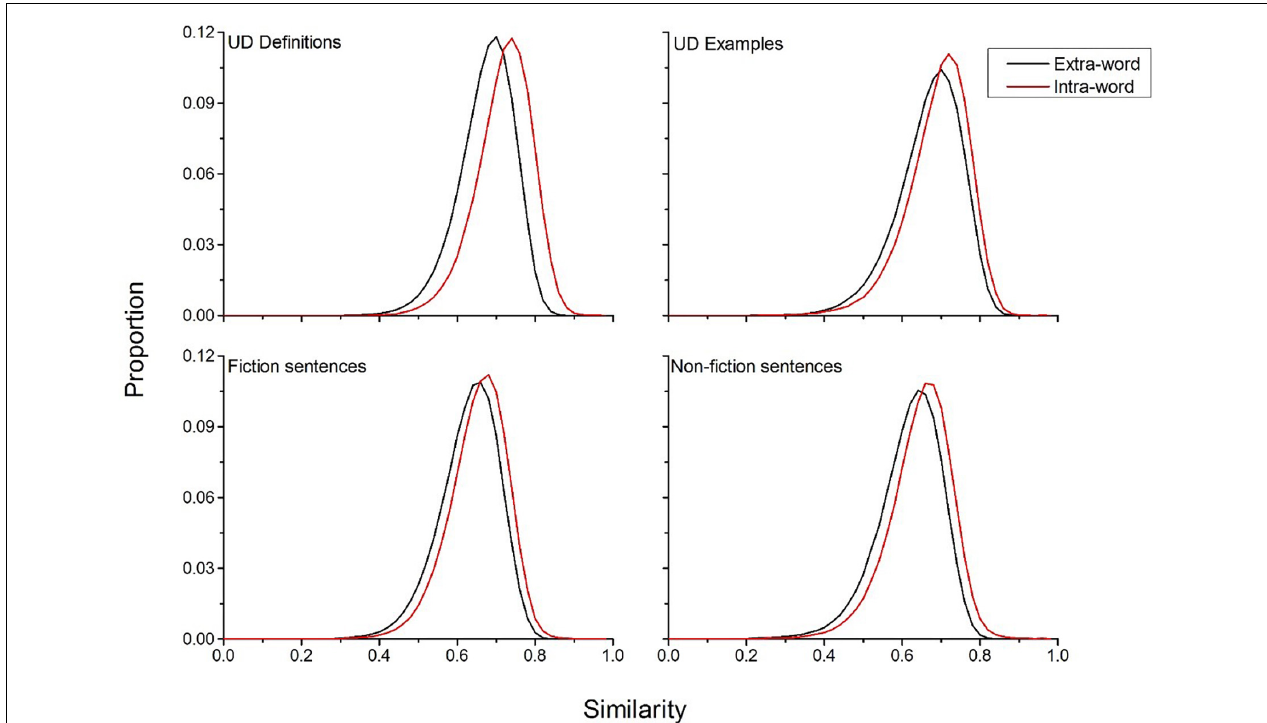
FIGURE 3 | Comparison of extra- and intra-word similarity for the UD definitions and examples and sentences from the fiction and non-fiction corpora. The results of this simulation show that the definitions and example usages that UD users are at least as discriminative for a word’s meaning as sentences from standard natural language